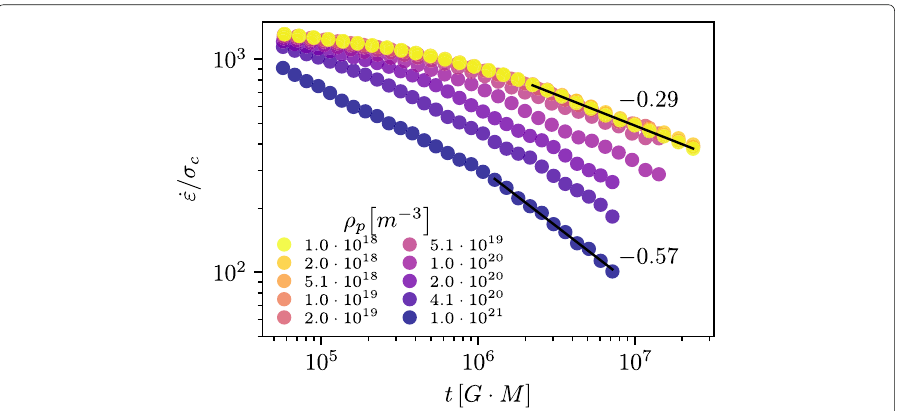
Fig. 2 Simulations of power-law relaxation of dislocation systems with varying ρ p . The figure shows the average strain rate during constant loading with σ c (ρ p ) . The relaxation becomes more rapid and the transient time before power-law decay of ˙ ε decreases as ρ p is increased above some threshold value of ρ c